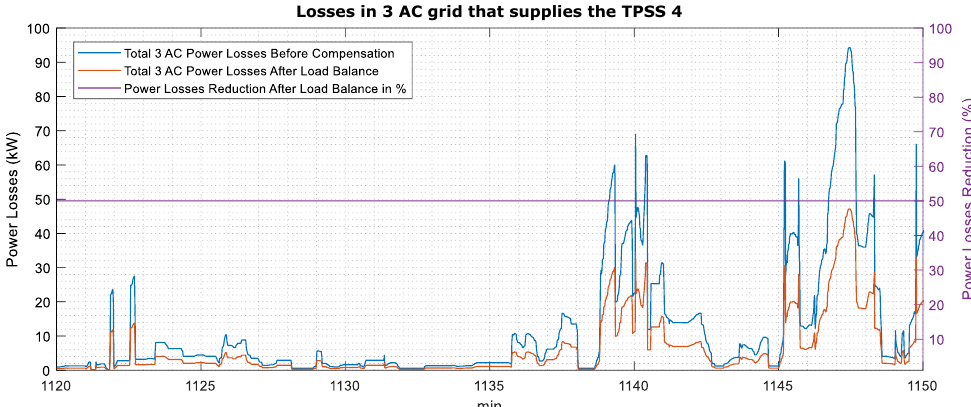
Figure 16. Losses in the three-phase grid supplying TPSS 4 when TPSS 5 is out of